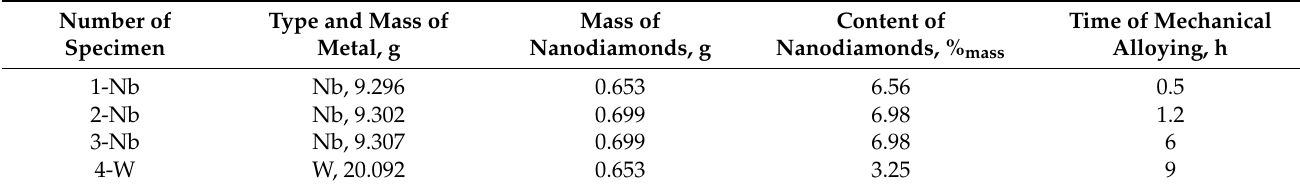
Table 3. Composite materials fabricated using mechanical